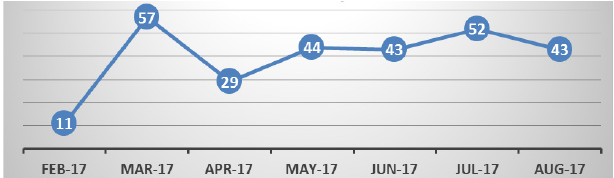
Figure 1. Absolute Number of Travelers Visiting the Travel Clinic by